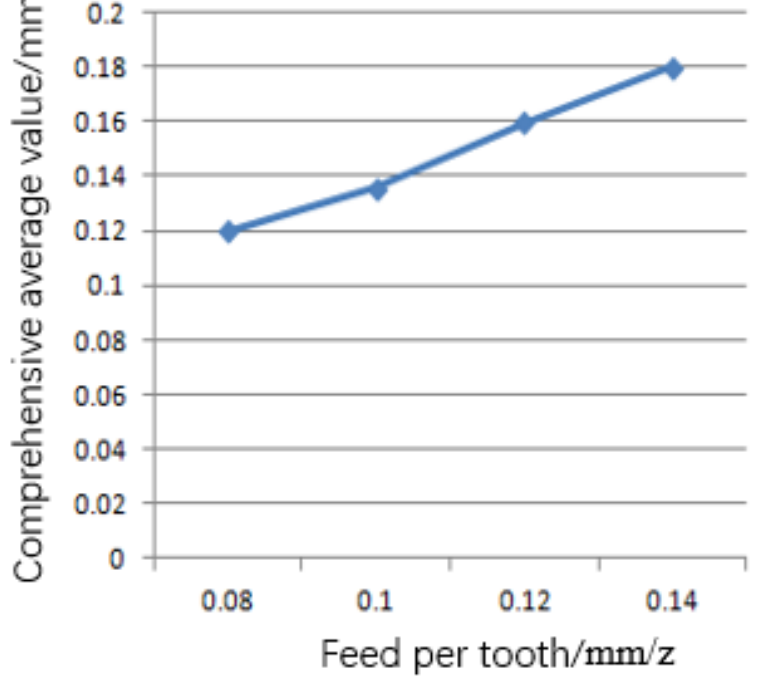
Figure 7. Influence on deformation of different feeds per tooth.